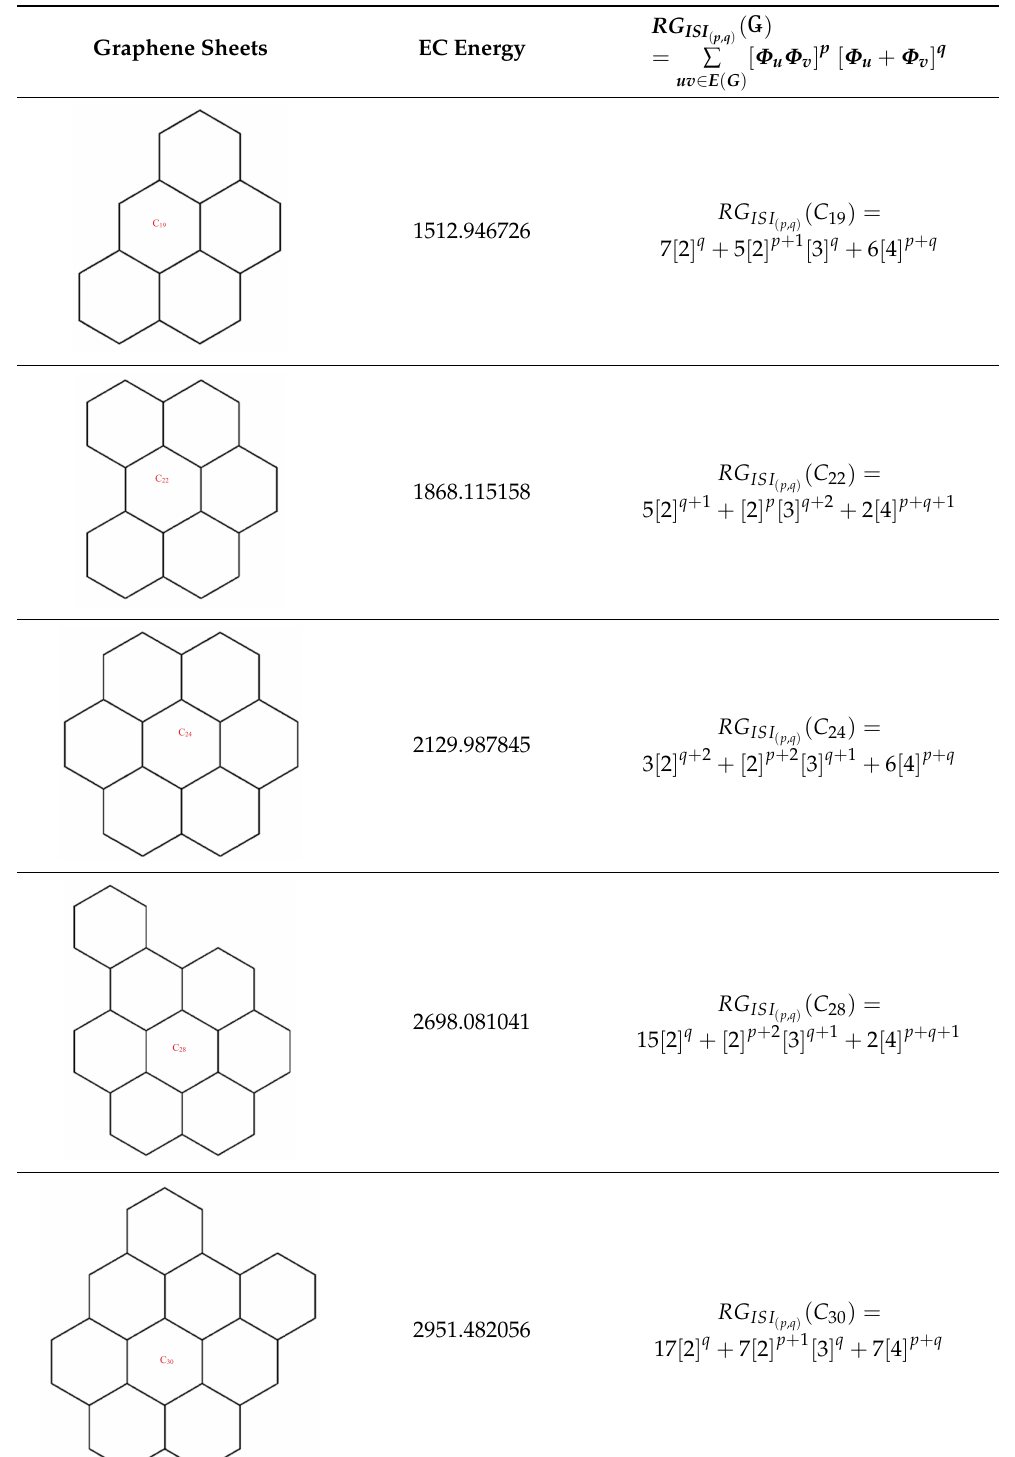
Table 1 Some reverse degree-based topological descriptors derived from the reverse general inverse sum indeg descriptor by assigning specific values to the parameters 𝑝 and 𝑞 .